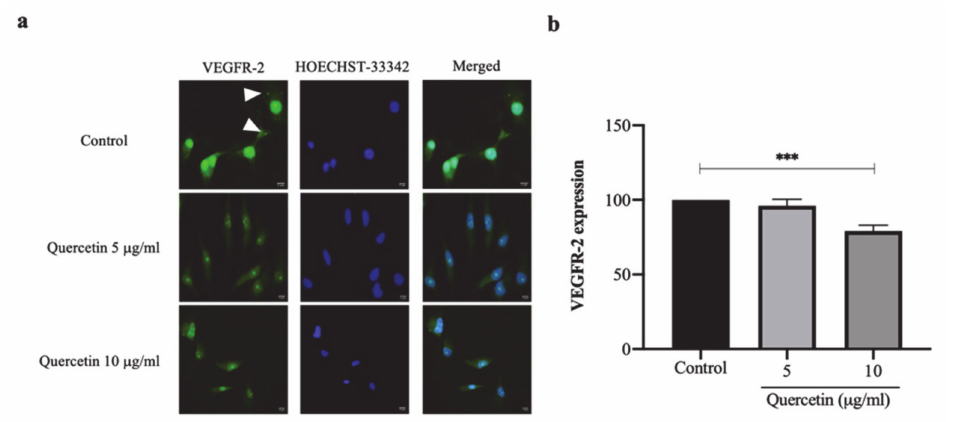
Figure 5. Quercetin significantly decreased VEGFR-2 expression in HT-29 cells-induced HUVECs. HUVEC cells were co-cultured with HT-29 cells with or without quercetin in polycarbonate Mem- brane Transwell ® Inserts with 3 µ m pore for 24 h and observed VEGFR-2 expression by immunofluo- rescence assay. ( a ) Immunofluorescence images of VEGFR-2 as represented in green and localization as shown in white arrowhead. Hoechst-33342 as represented in blue for nuclear staining. Scale bar: 5 µ m. ( b ) The fluorescent intensity of VEGFR-2 expression was calculated and presented as % of control. Bar graph expressed as means ± SD, n = 3, *** p <